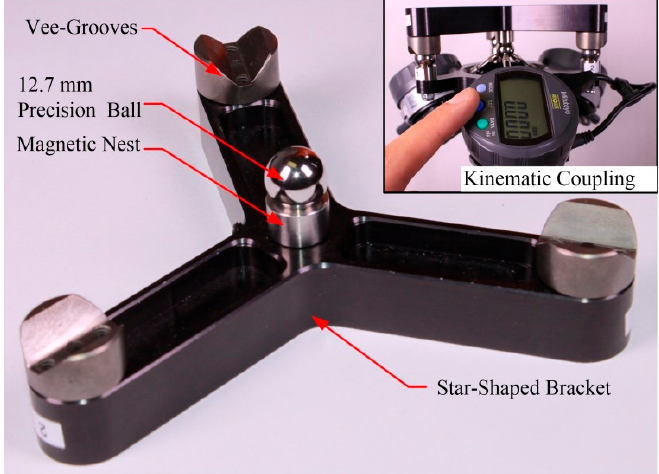
Figure 4. Kinematic coupling platform.